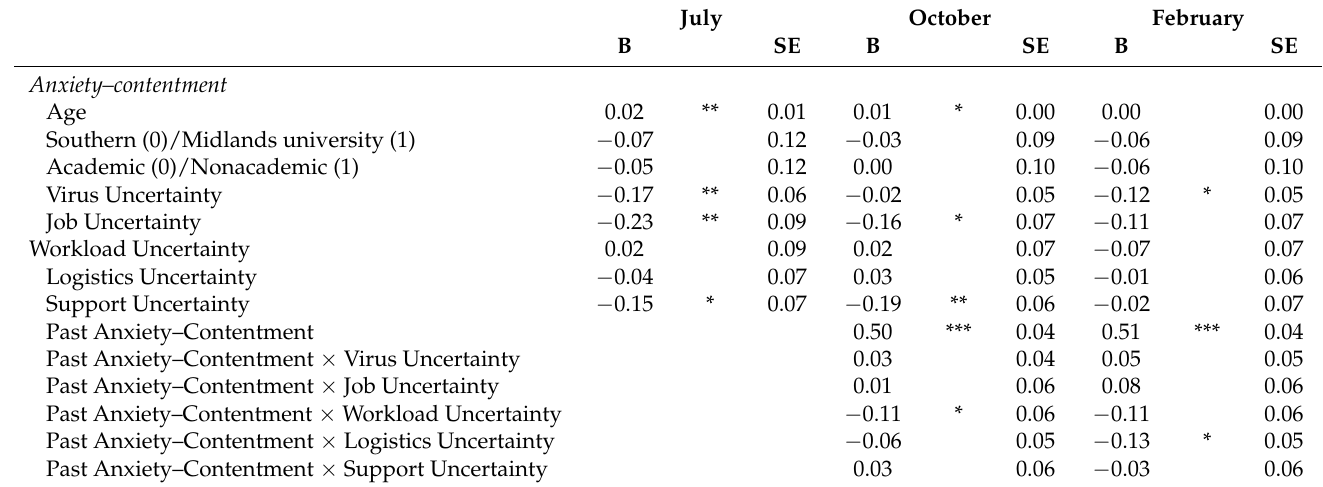
Table 6. Effects of uncertainty on changes in well-being (Hypothesis 2) and interactions between uncertainty and past well-being (Hypothesis